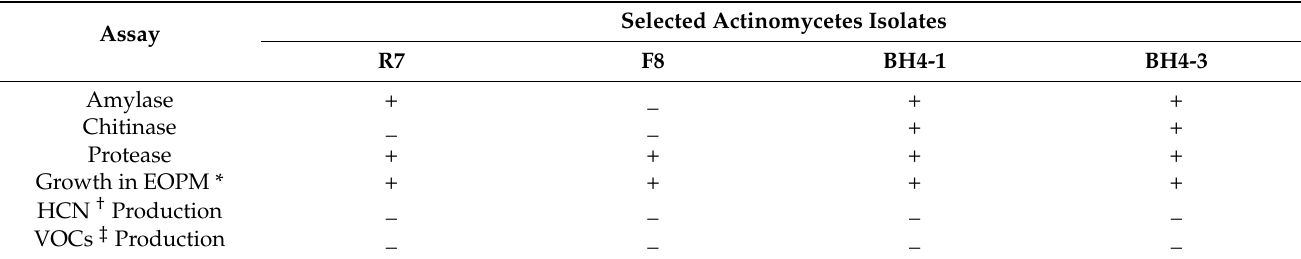
Table 2. Results of biochemical assays performed on four selected actinomycetes isolates. Assay